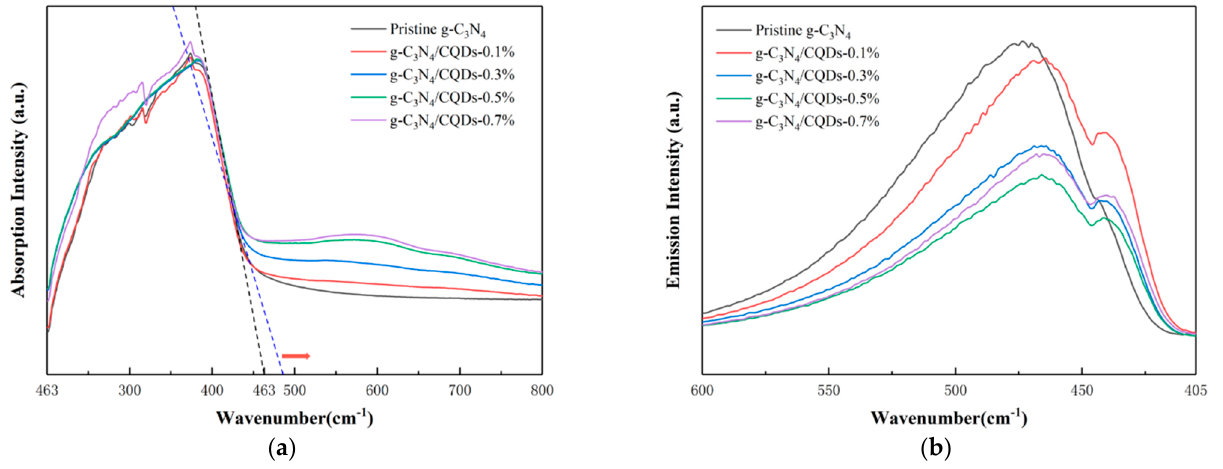
Figure 4. ( a ) UV − vis absorption spectra and ( b ) PL spectra of g-C 3 N 4 with different content of CQDs from